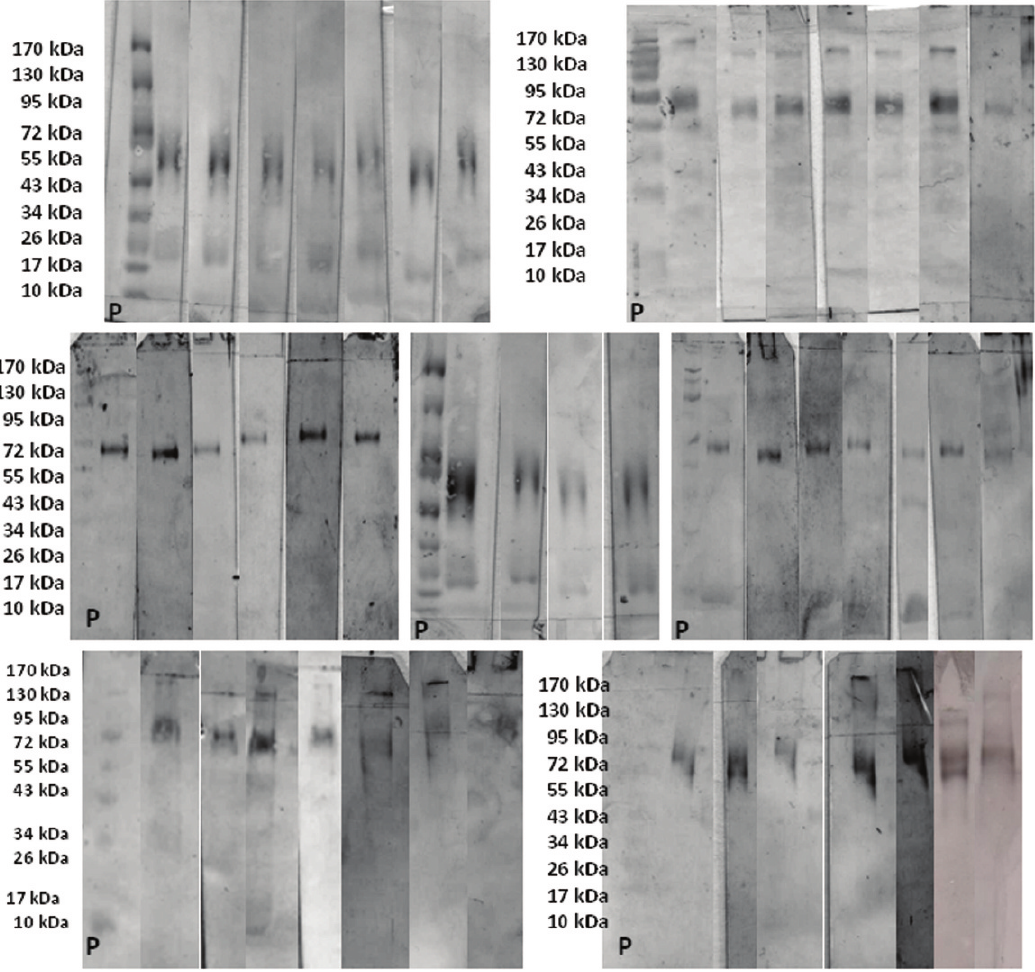
Figure 1 - Purified beta-lactoglobulin electroblotted on 0.45- m m pore-size nitrocellulose membranes after incubation with patient’s serum, primary antibody (goat IgG anti-human IgE), secondary antibody (HRP-conjugated rabbit anti-goat IgG) and DAB revelation, demonstrating bands of s-IgE against b -lactoglobulin at 72 kDa ( b -Lg tetramers), 36 kDa ( b -Lg dimers) and 18 kDa ( b -Lg monomers) from patients in group A. Lane P=pre-stained 10-170 kDa molecular mass protein ladder (PageRuler H ,